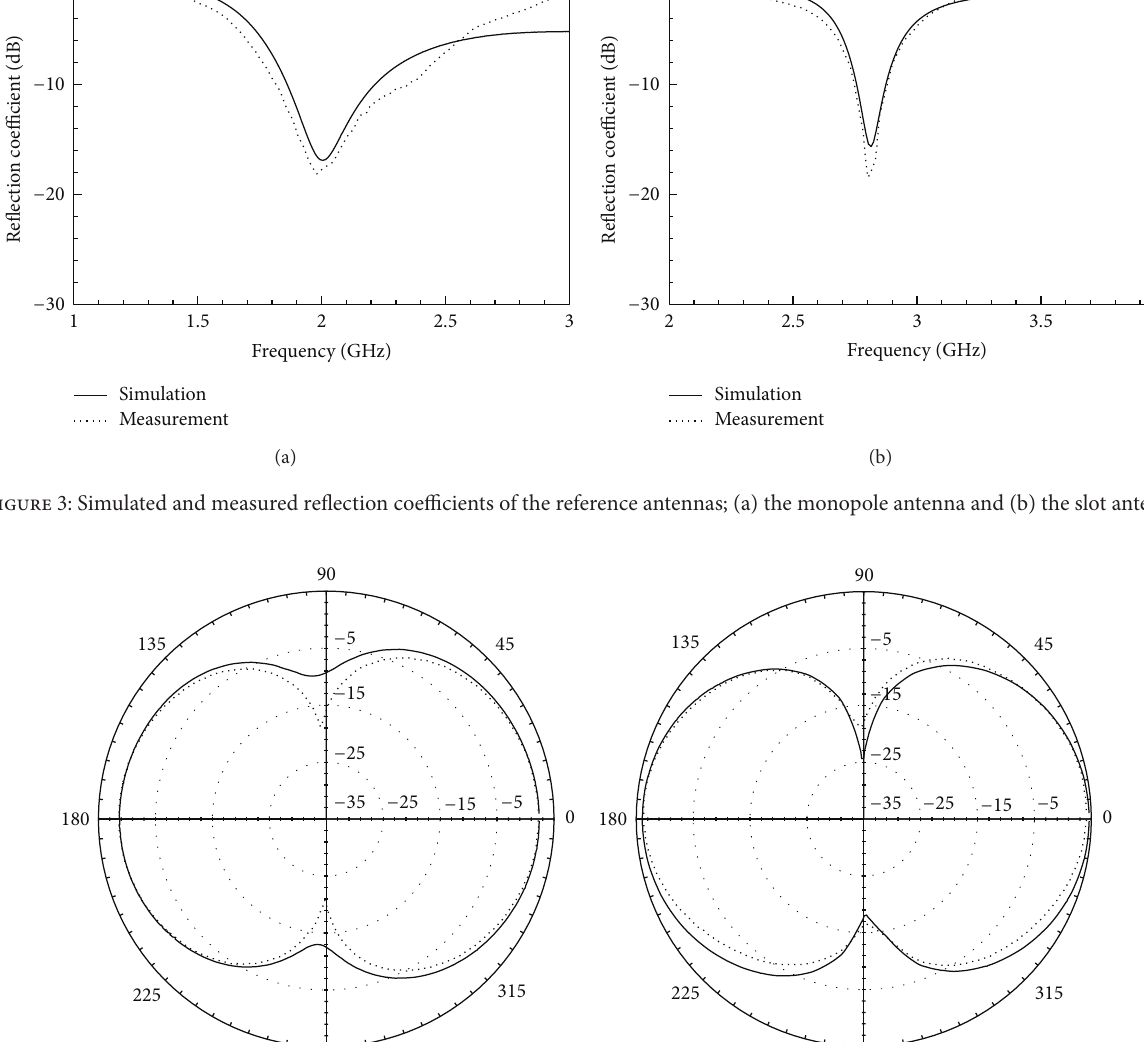
the same substrate (FR-4). The thickness of the substrates